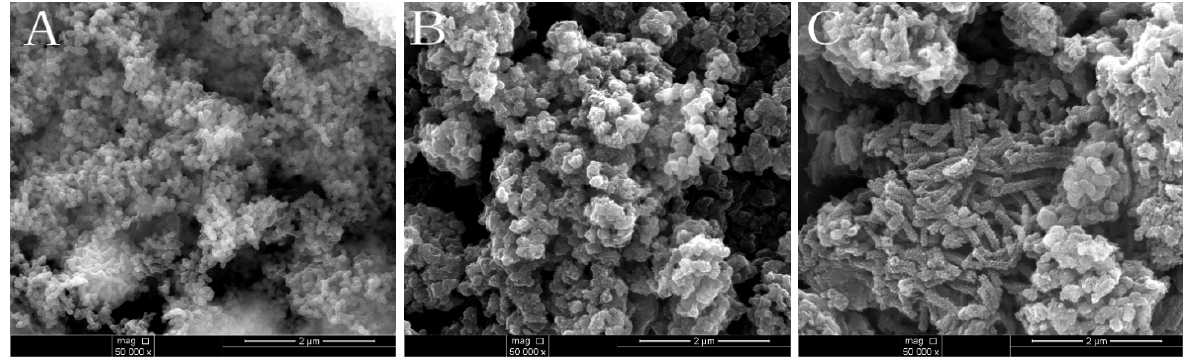
Figure 2. SEM images of samples: ( A ) mesoporous silica; ( B ) PANI-silica; and ( C ) bulk